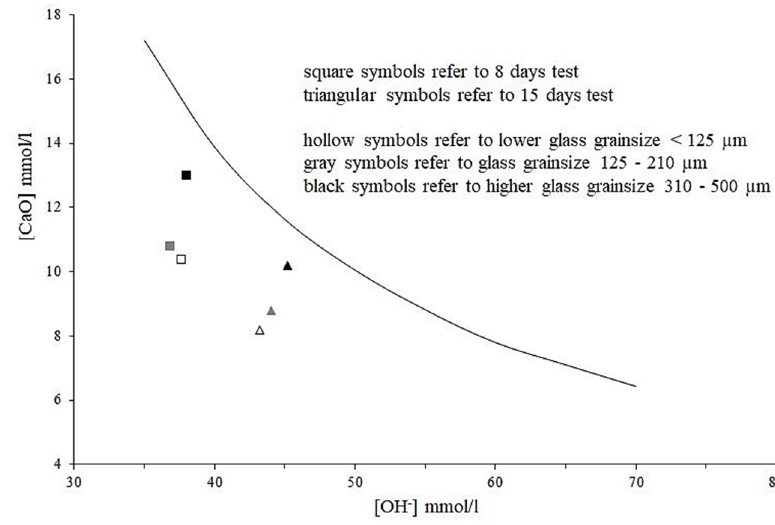
Figure 3. Pozzolanic test results.